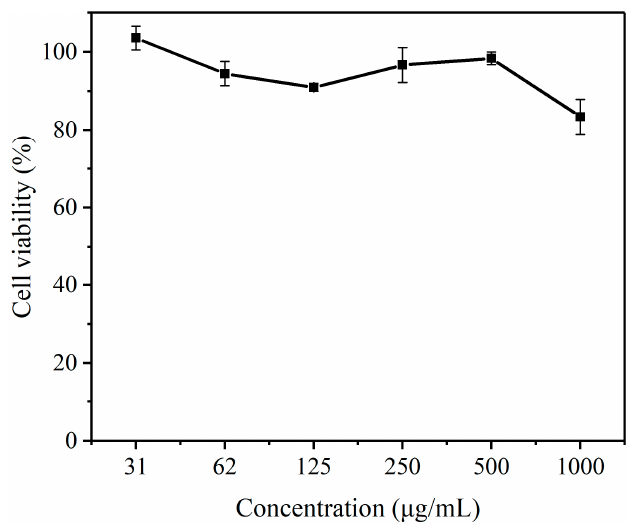
Figure 8. Cell viabilities of HeLa cells incubated with polymer micelles for 24 h (n = 3, mean ± SD).